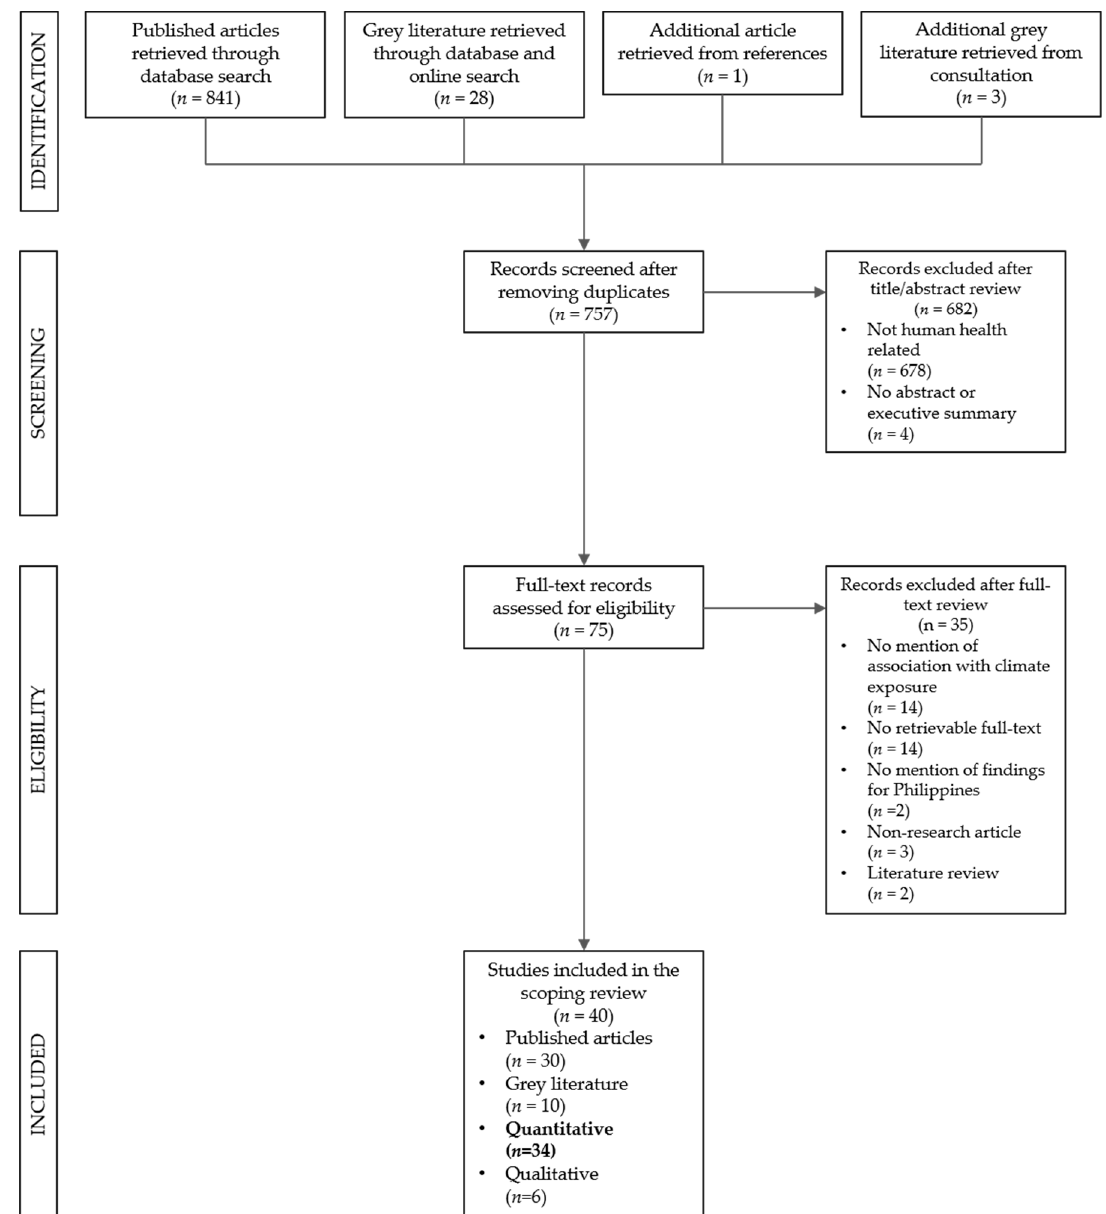
Figure 1. Preferred Reporting Items for Systematic Reviews and Meta-Analyses (PRISMA) flowchart of selection process.